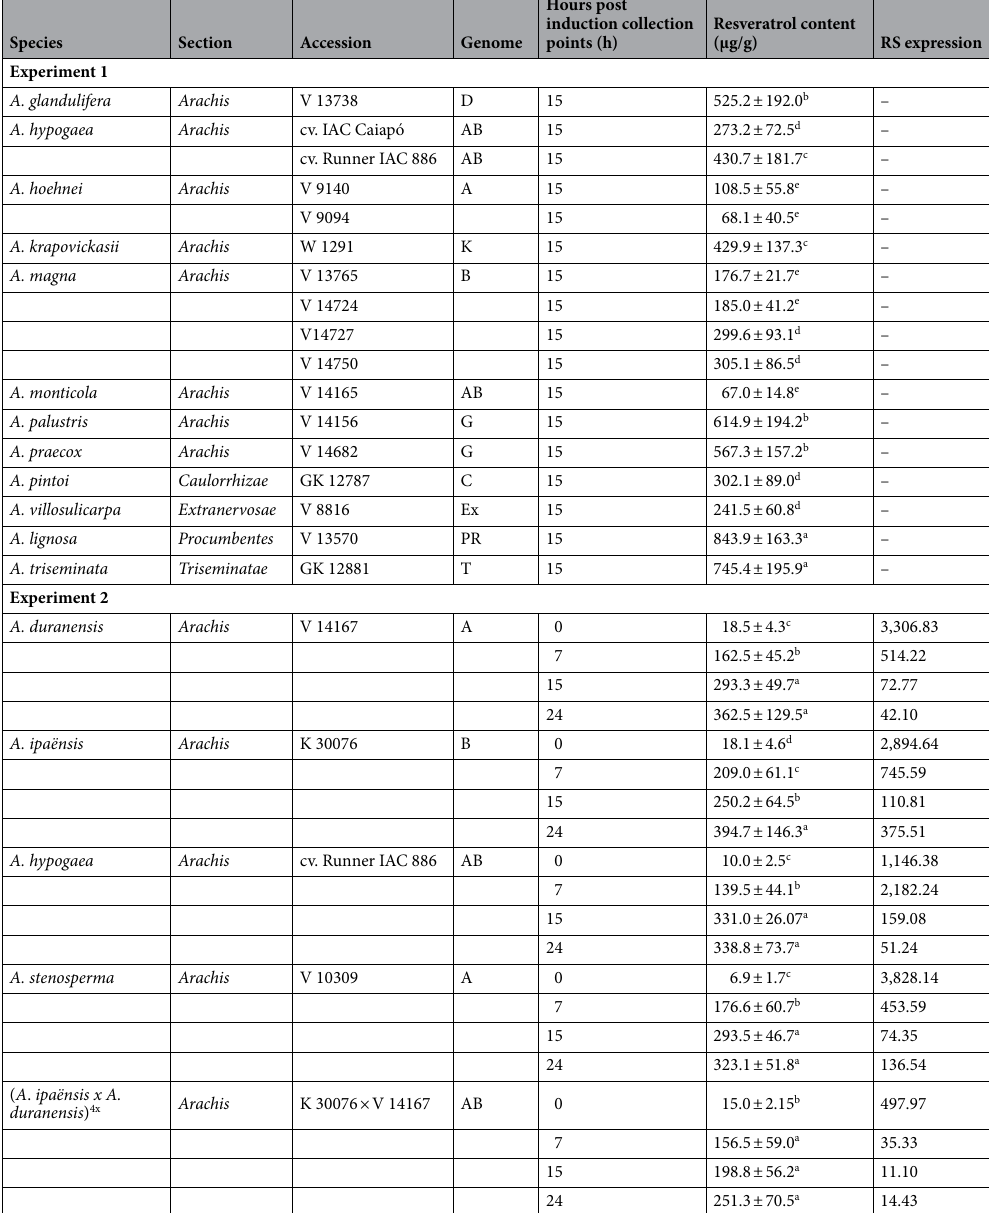
Table 1. Arachis genotypes analyzed, their genome type and content of resveratrol and resveratrol synthase (RS) expression estimated after UV exposure. Means followed by the same letter do not differ (α < 0,05) according to Scott-Knott test. Collectors: G = W.C. Gregory; K = A. Krapovickas; V = J.F.M.